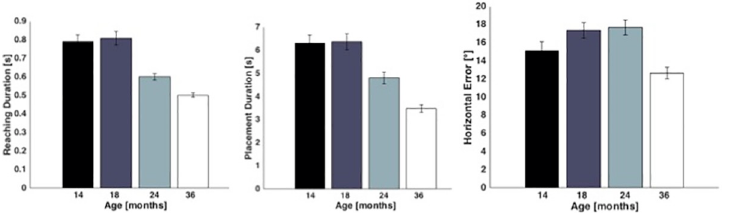
Fig 3. Significant age effects: Means ± SE are